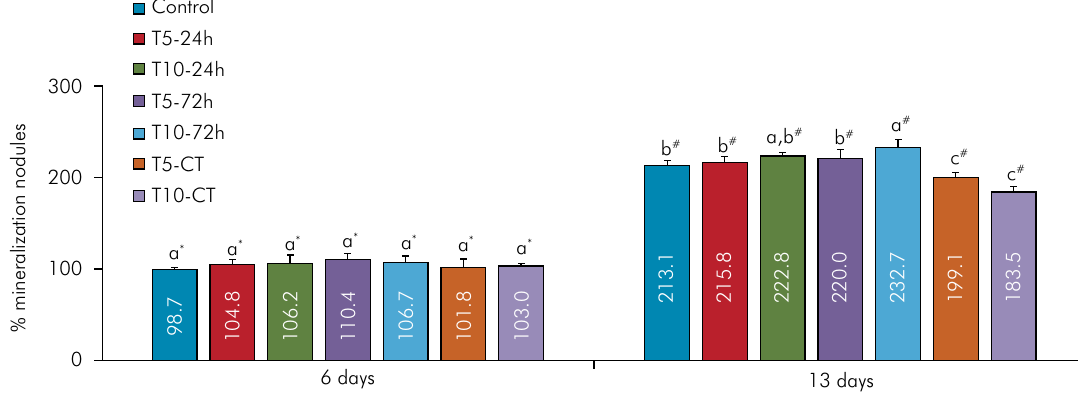
a Different lowercase letters show statistical difference among the groups at each time point. Control: DMEM with 10 µM DMSO; *Different symbols show statistical difference among the time points, considering each treatment condition separately. (ANOVA and Tukey test; p < 0.05). Figure 4. Mineralized nodule formation (means/standard deviations) at the time points of 6 and 13 days of the treatment with taxifolin at 5 and 10 µM for 24h, 72h and continuous treatment (CT), using alizarin red